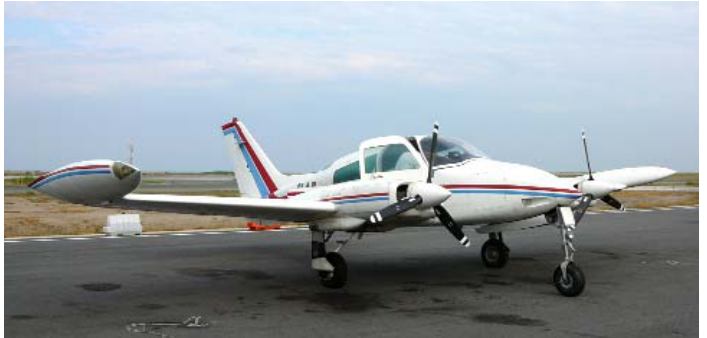
Figure 1 . The CESSNA 310Q two-engined aircraft which is the platform of